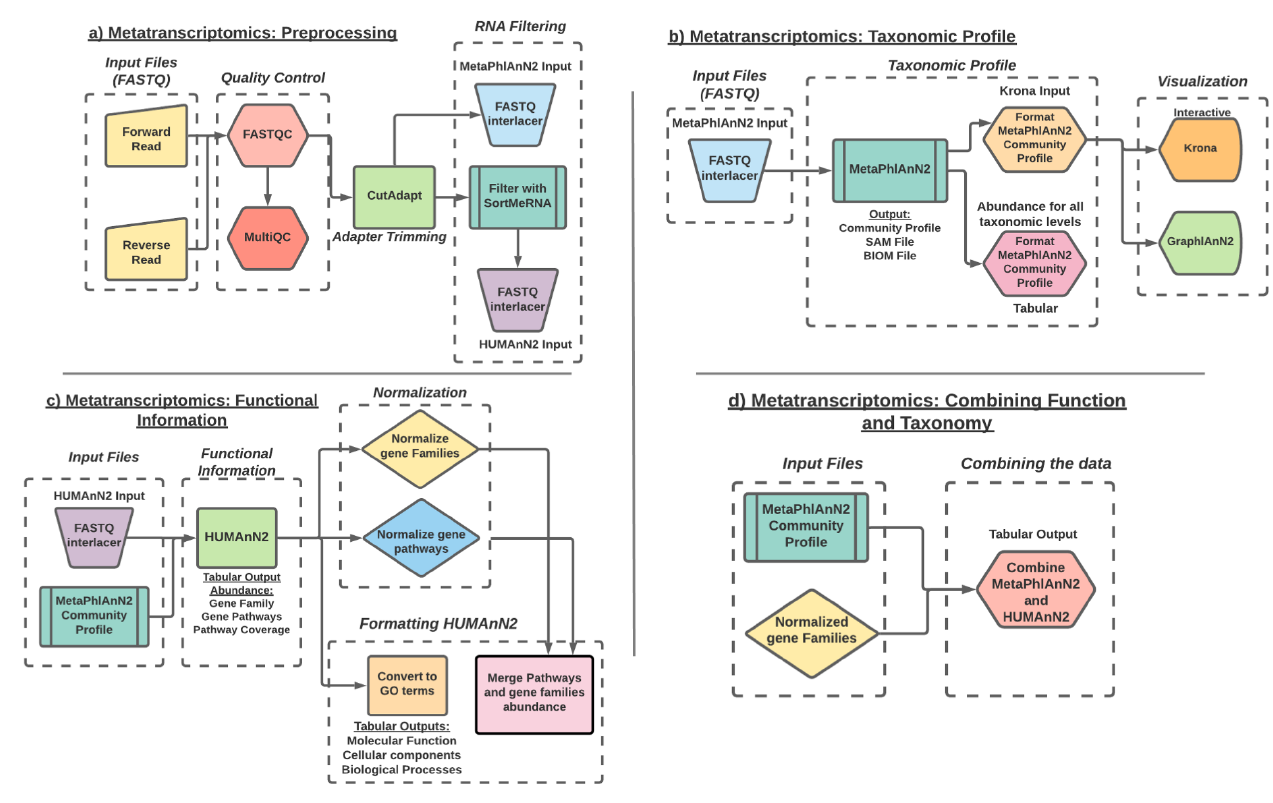
Figure 2. Diagram of the ASaiM-MT workflow. a ) Preprocessing workflow: Workflow representation of the tools involved in quality check, data trimming and RNA filtering. b ) Taxonomic profile workflow: workflow representation of taxonomy assignment tool (MetaPhlAn2) and post processing of the data using the Format MetaPhlAn2 tool. The workflow includes visualization of the data using interactive Krona and GraPhlAn plots. c ) Functional information workflow: representation of tools involved in functional annotation (HUMAnN2), normalization of the data d ) Combine Functional-Taxonomy abundance workflow: workflow representing tools that combines (Combine MetaPhlAn2 and HUMAnN2 outputs) and groups (Group abundances into GO slim terms) the functional and taxonomy